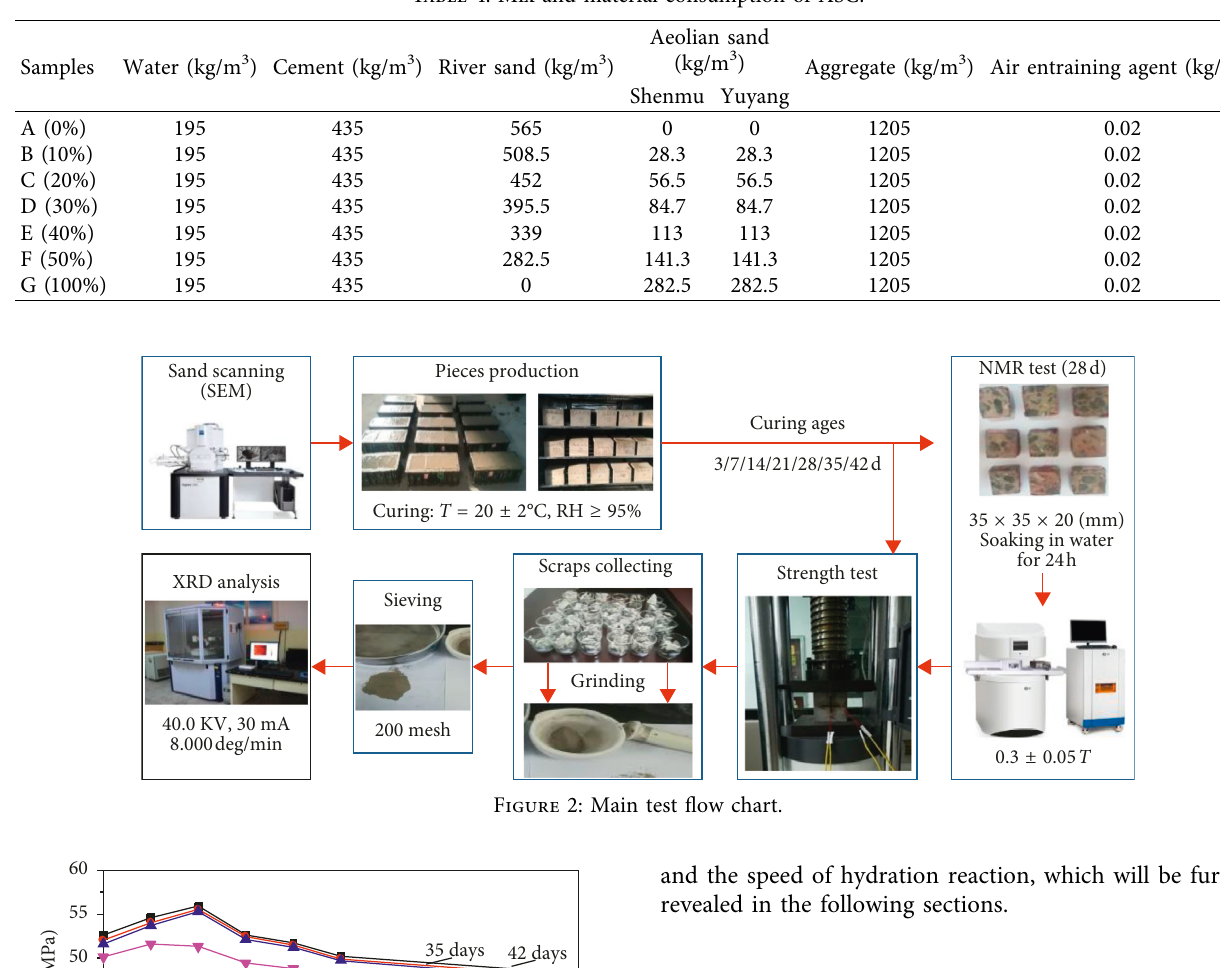
Table 4: Mix and material consumption of ASC.